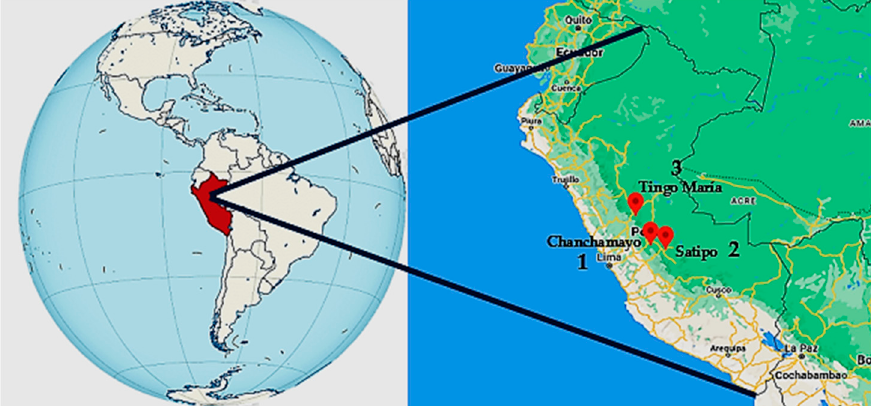
Figure 2. Location of the headquarters for the evaluation of hygiene quality of the beer company, presented in the following order: Chanchamayo (1), Satipo (2), Tingo Maria (3).